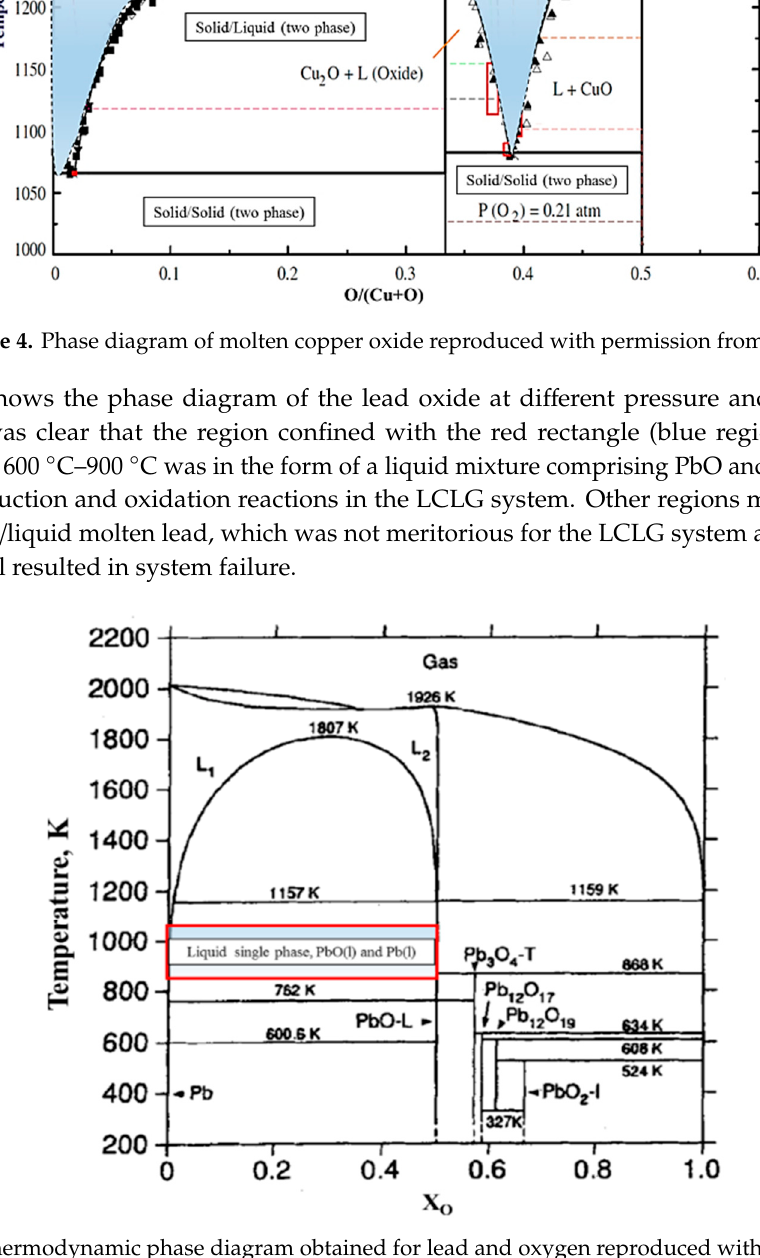
Figure 5. Thermodynamic phase diagram obtained for lead and oxygen reproduced with permission from [25].